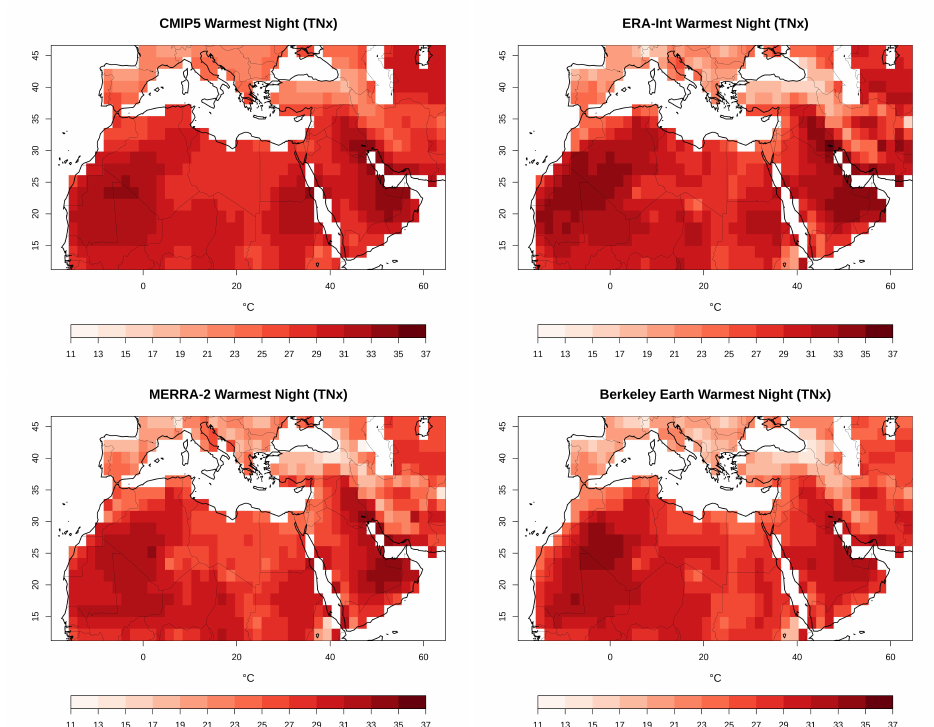
Figure 2. 1980–2018 climatology of the Warmest Night (TNx) for the: CMIP5 multi-model ensemble mean ( top left ), ERA-Interim ( top right ), MERRA-2 ( bottom left ), and Berkeley Earth ( bottom right ).